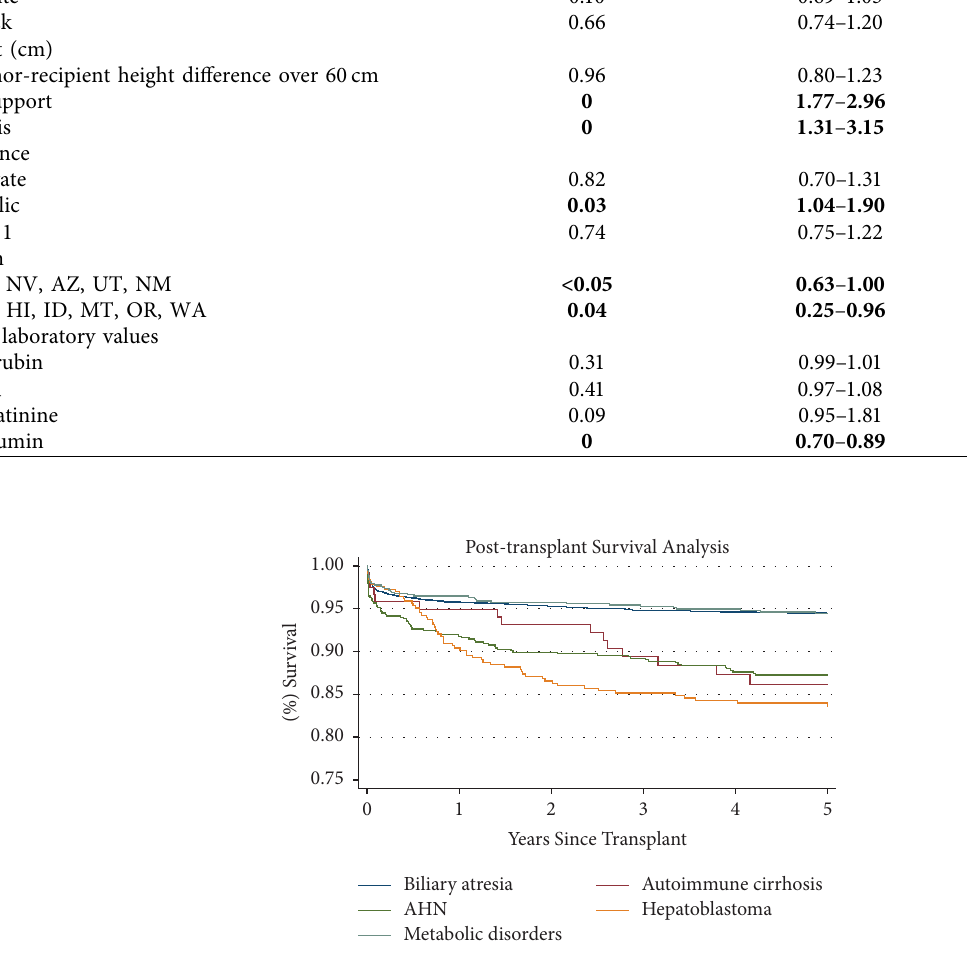
Figure 3: Post-transplant survival analysis. Kaplan–Meier survival function over 5 years for patient survival in pediatric patients who underwent liver transplant from transplantation until death, by